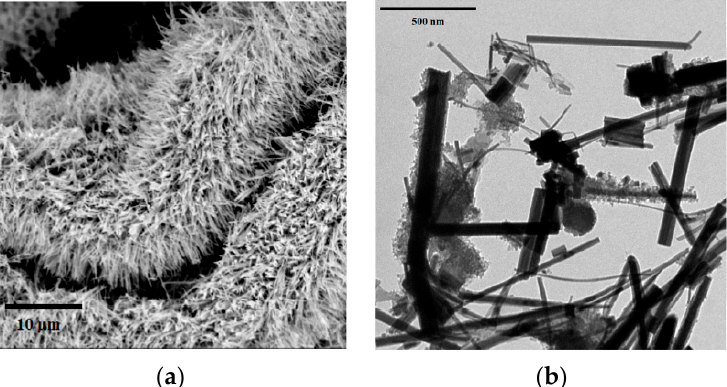
Figure 2. ( a ) Surface sensor’s E-SEM image nanowires carpet doped with cobalt oxide nanoparticles; ( b ) TEM image of WO 3 nanowires and Ag 2 O nanoparticles.